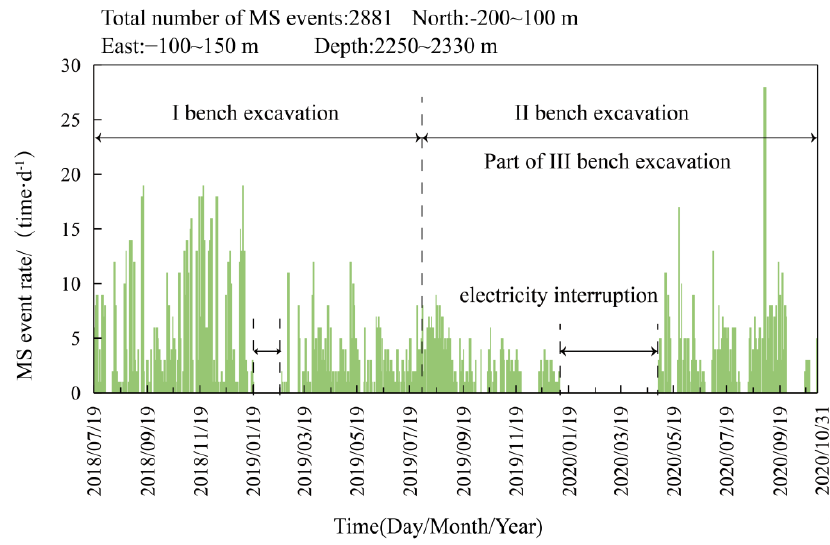
Figure 4. Temporal distribution of MS events from 19 July 2018 to 31 October 2020.